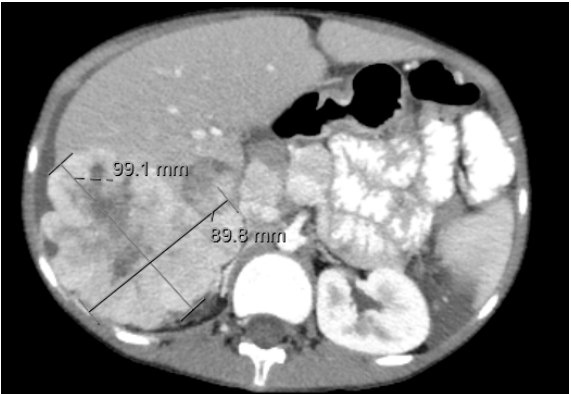
Figure 10. CT Imaging of Hepatocellular Carcinoma. Irregular heterogeneously enhancing mass is present in the right hepatic lobe, extending exophytically, laterally, and inferiorly from the liver surface, measuring up to 9.9 × 9.0 cm in maximum transaxial diameters with central hypoattenuation, suggesting necrosis. There is nodular extension along the peritoneal surface lateral to the right hepatic lobe, as well as more anteriorly.